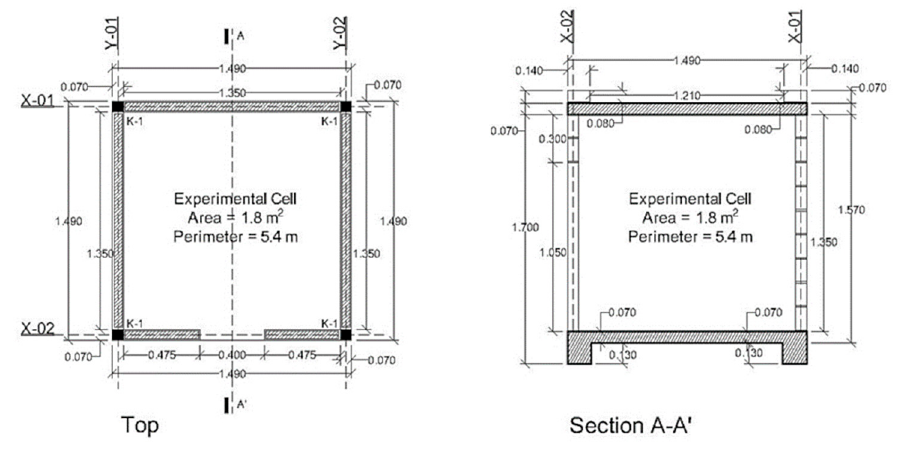
Figure 4. Top and section drawings of the test cell.